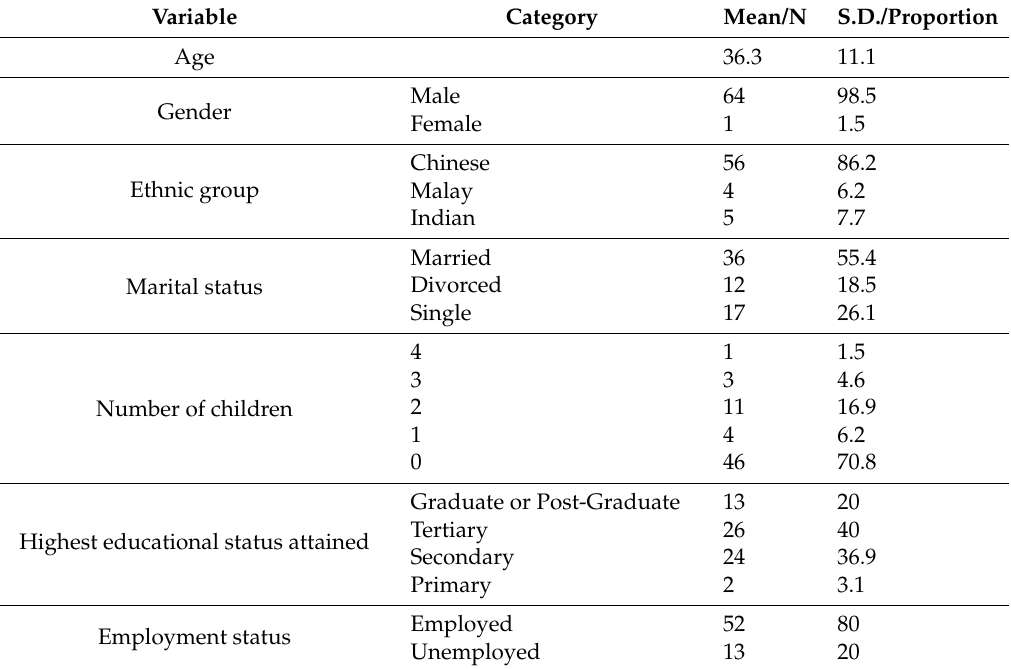
Table 1. Socio-demographics of sample (n = 65).